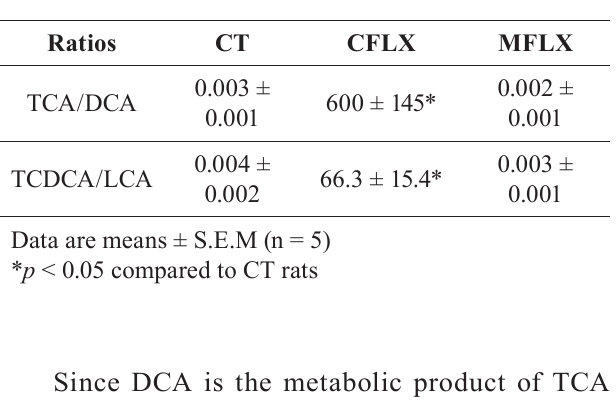
TABLE III - Effect of ciprofloxacin and moxifloxacin on TCA/DCA and TCDCA/LCA in intestine Ratios